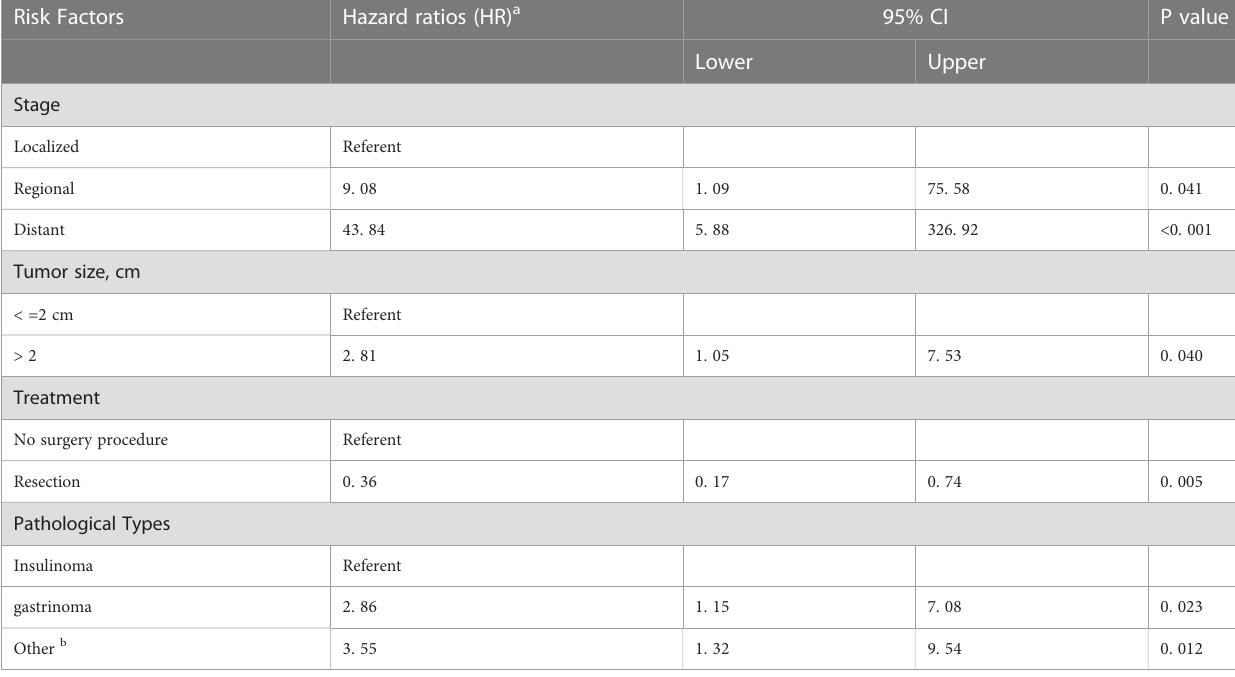
TABLE 2 Univariate Cox ’ s proportional hazards model assessing factors associated with mortality after diagnosis of F-PNET with multiple